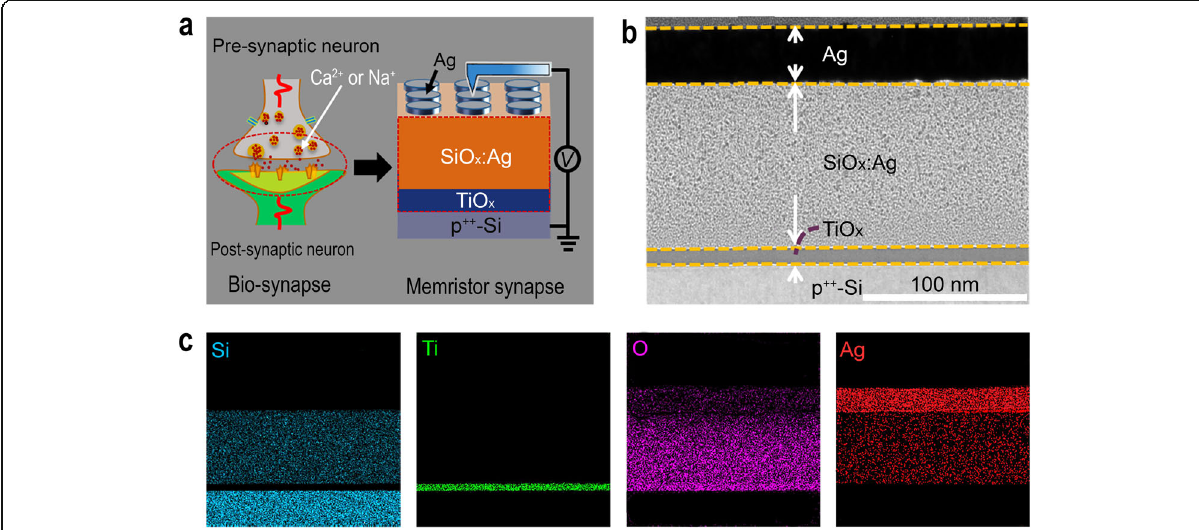
Fig. 1 Schematic of the Ag/SiO x :Ag/TiO x /p ++ -Si memristor device and its cross-sectional TEM analysis. a Schematic illustration of the device and analogy between the biological synapse and electronic synapse. b Cross-sectional TEM view of a single memristor unit of Ag/SiO x :Ag/TiO x /p ++ -Si structure. The SiO x :Ag and TiO x thin films sandwiched between Ag TE and p ++ -Si BE electrodes. c The elemental mapping of the device